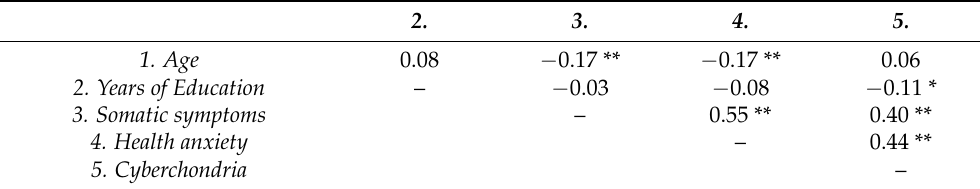
Table 2. Pearson’s r correlations among the investigated variables 2 .